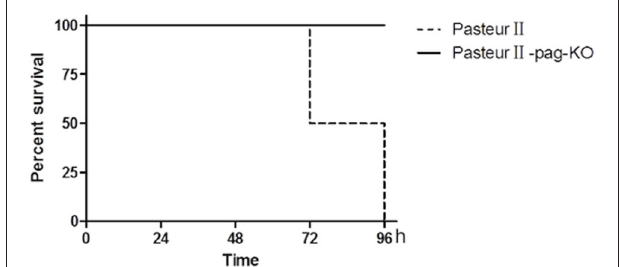
FIGURE 4 | Effect of pag on pathogenicity of B. anthracis in BALB/c mouse model of infection. Six mice each were infected with either Pasteur II (dashed line), or PasteurII-pagKO strain (solid line), Percent of surviving mice shown as a function of time in hours post-infections. The difference of animal survival was statistically analyzed using Fisher exact test. P <